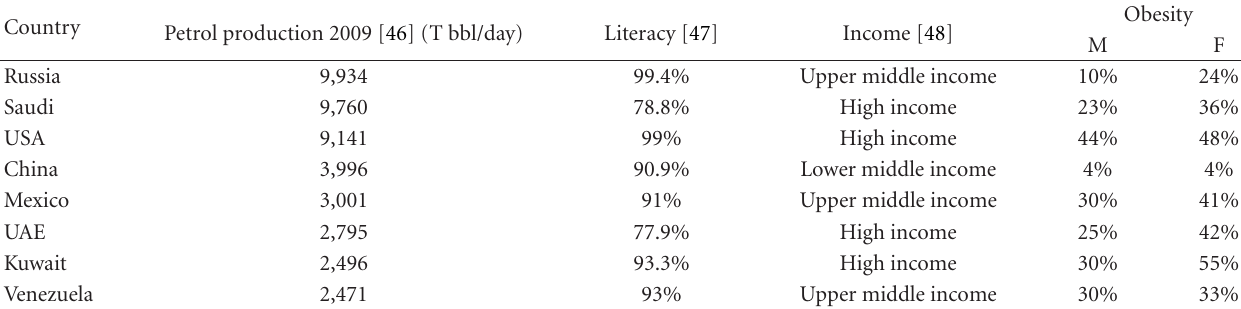
Table 3: Obesity prevalence in oil-producing countries in males and females aged between 15 and 100 WHO, 2010, and their income and literacy rates.